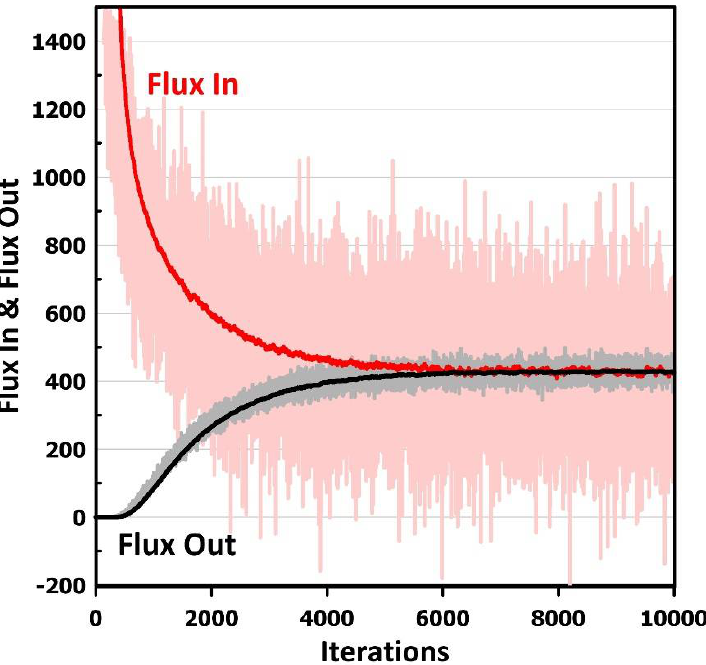
Figure 5. The plot of the typical fluxes in molecules at the upstream and downstream sides of the MMM using the lattice MC (MC1). The light color plots represent the instantaneous fluxes, whereas the solid lines represent the moving average fluxes. Lattice: 41 × 41 × 41; ( x F , y F , z F ) = (27, 27, 27); D F = D P = 1 × 10 11 m 2 /s; S F = 0.10, S P = 0.50.